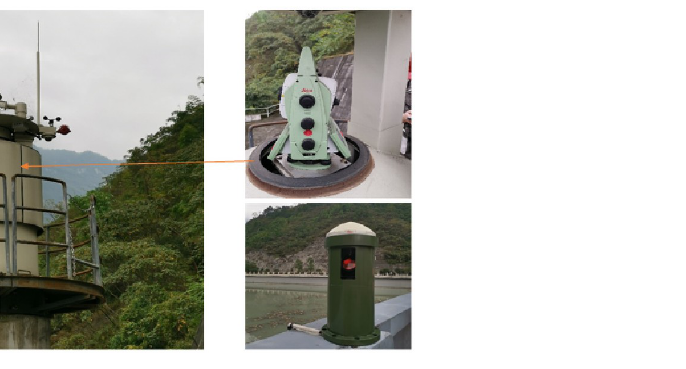
Fig 1. Dam deformation monitoring system based on robotic total